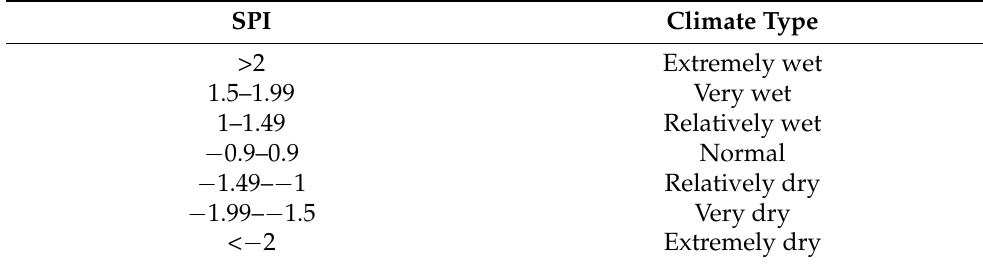
Table 1. The SPI classification of dry and wet